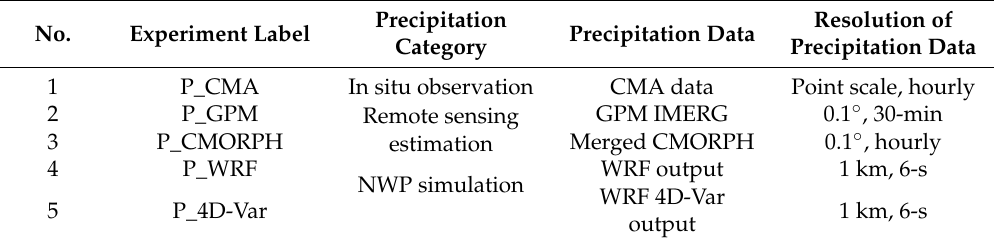
Table 4. Experimental design for the rainfall-runoff simulations with different precipitation